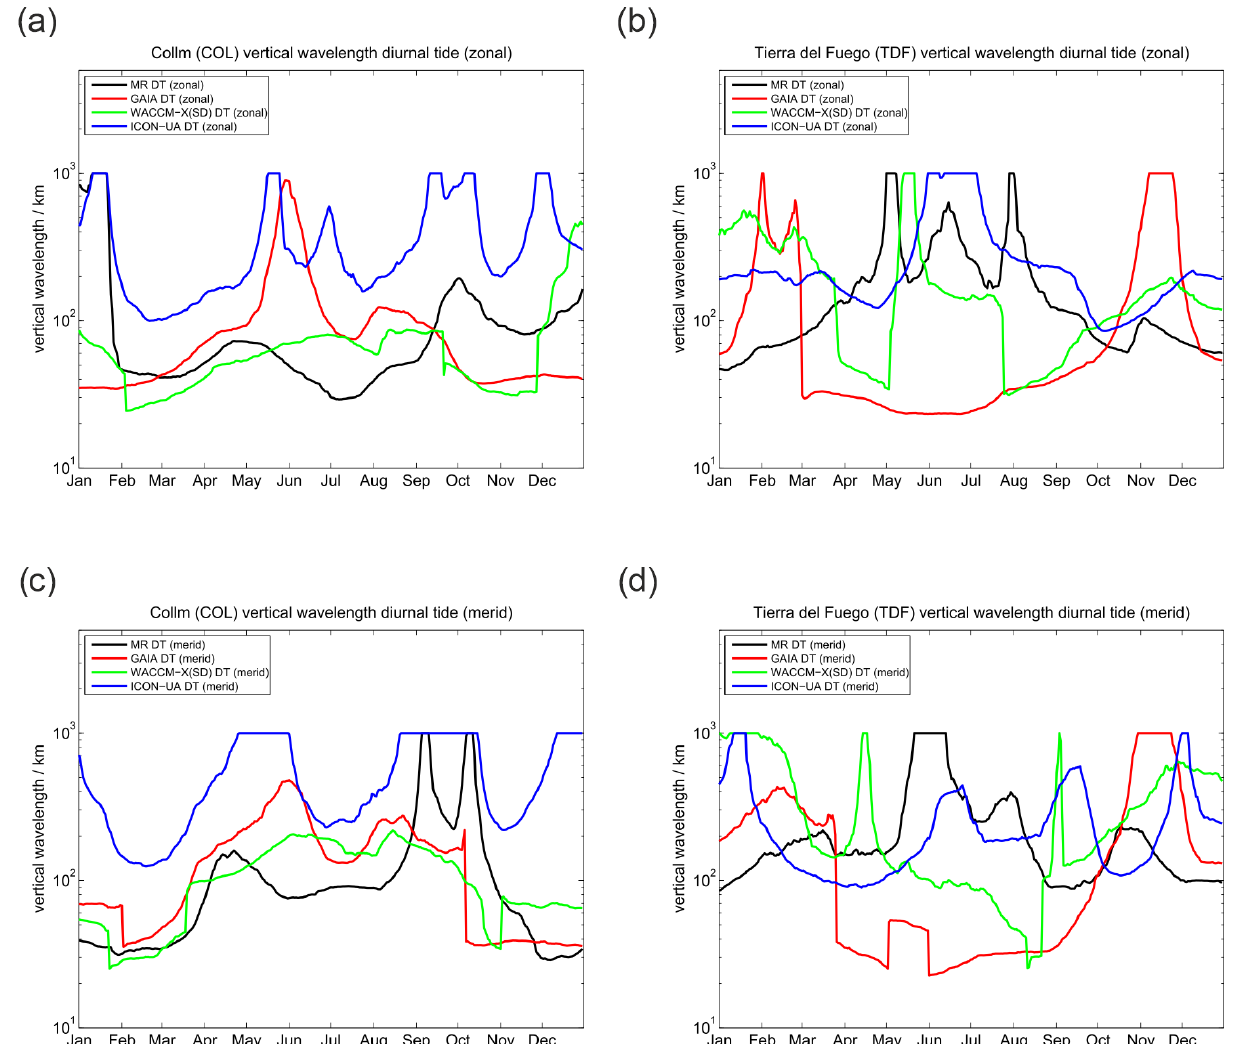
Figure 12. The same as Fig. 5, but for COL and